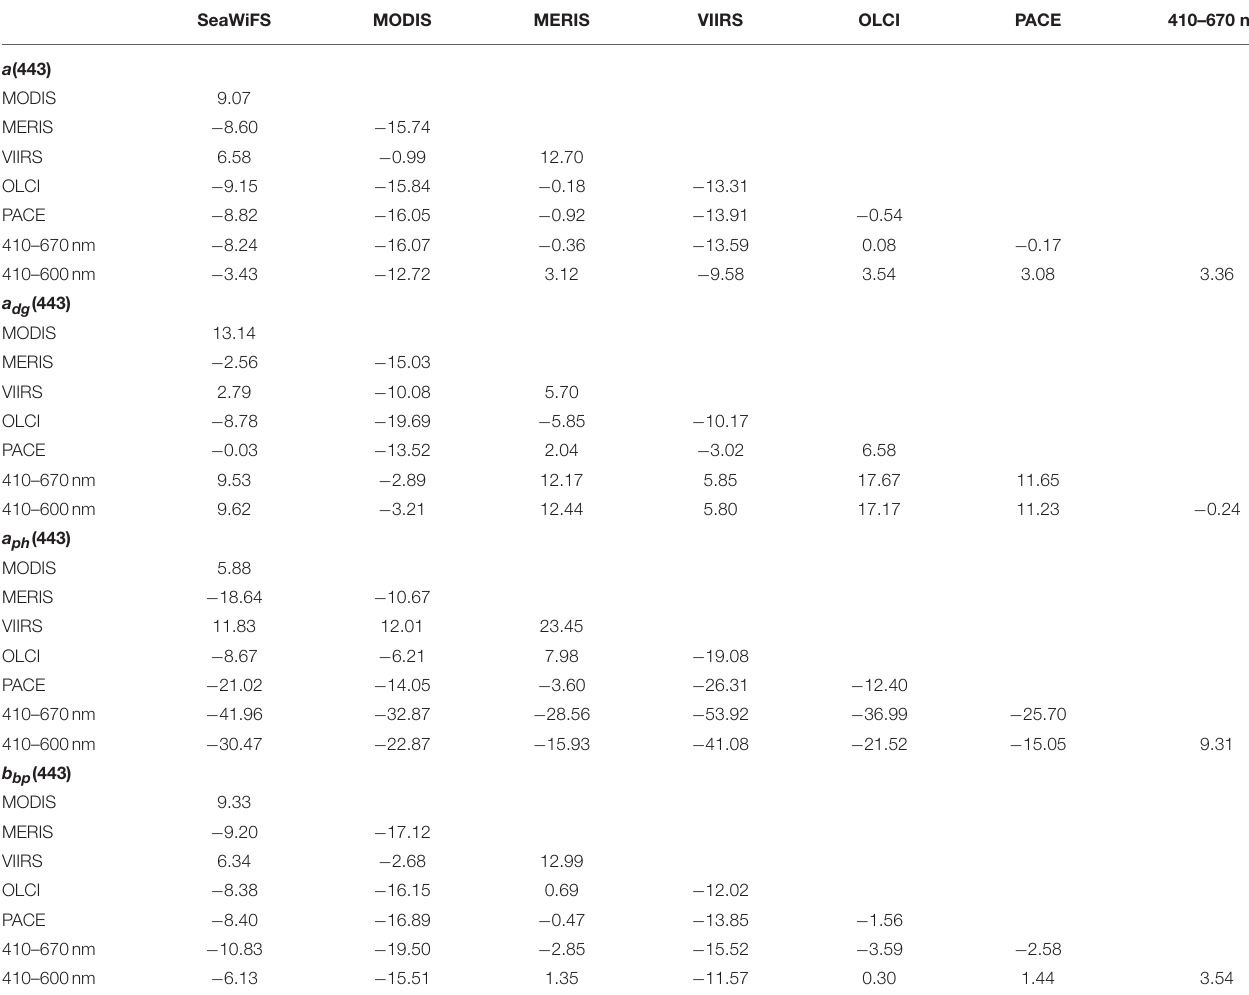
TABLE 4 | As in Table 2 , but for eutrophic water (1.0 < C a ≤ 5.0mg m − 3